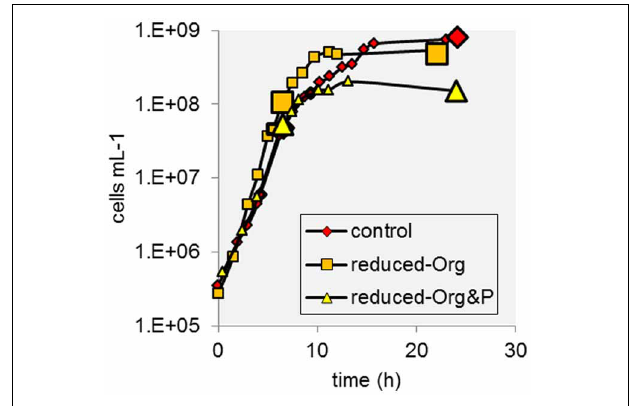
FIGURE 1 | Example growth curves of T. kodakarensis from each treatment. Sample harvests at exponential and stationary phase are indicated by enlarged data